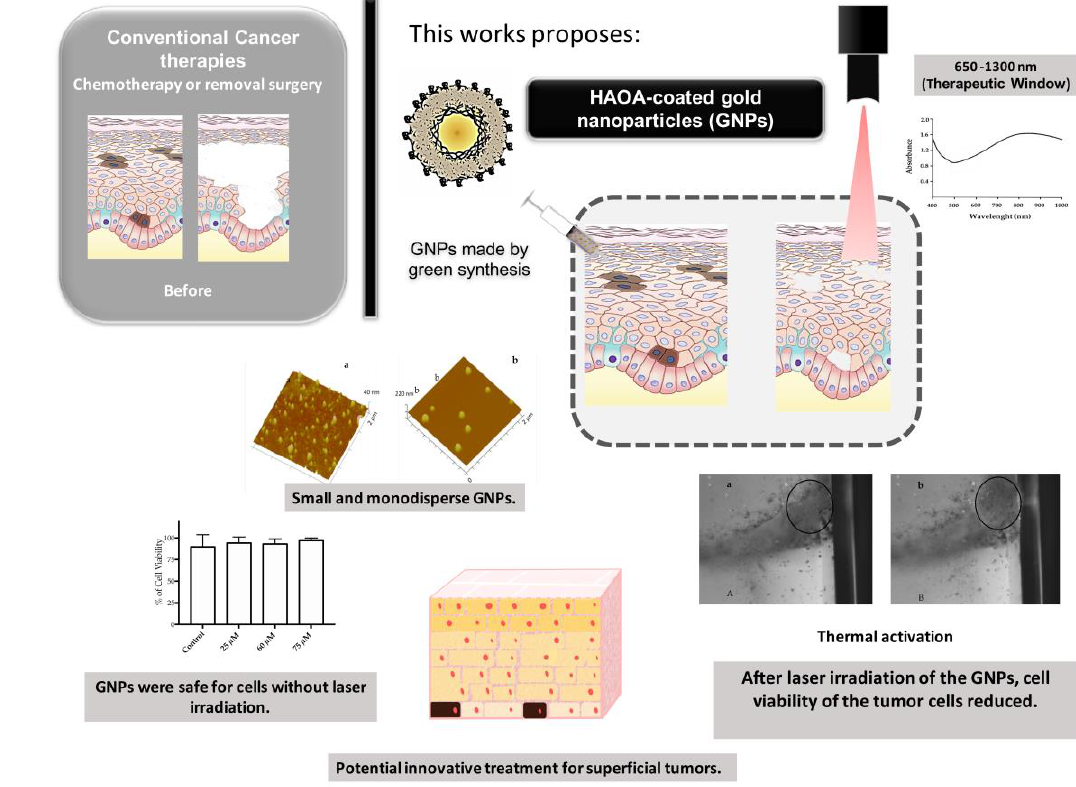
Figure 1. Schematic representation of the laser activation of HAOA-coated gold nanoparticles (GNPs). HAOA means hyaluronic acid and oleic acid.